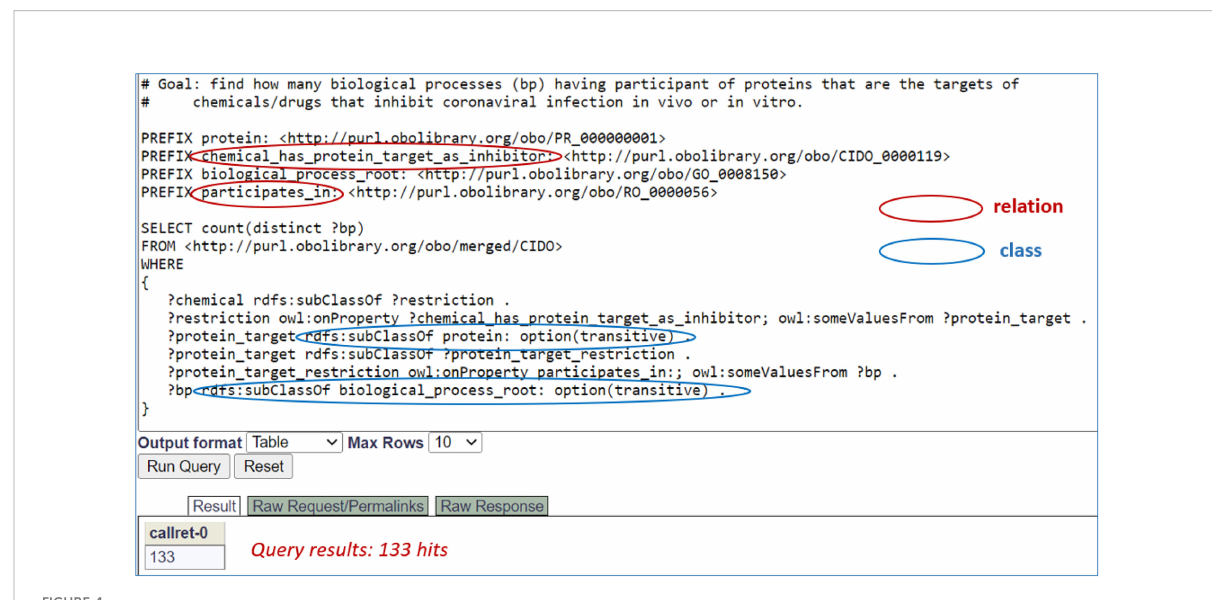
FIGURE 4 SPARQL query of CIDO for anticoronaviral chemicals/drugs out of host-coronavirus interactions. This SPARQL identi fi ed 125 biological processes having participant of proteins that are the targets of chemicals/drugs that inhibit coronaviral infection in vivo or in vitro , illustrating how the relations (red circles) and classes (blue circles) are associated and interlinked. The SPARQL was performed using Ontobee SPARQL endpoint (http://www.ontobee.org/sparql). The detailed information about these 125 biological processes and their associated proteins and chemicals/drugs is provided in Supplemental Files 1,